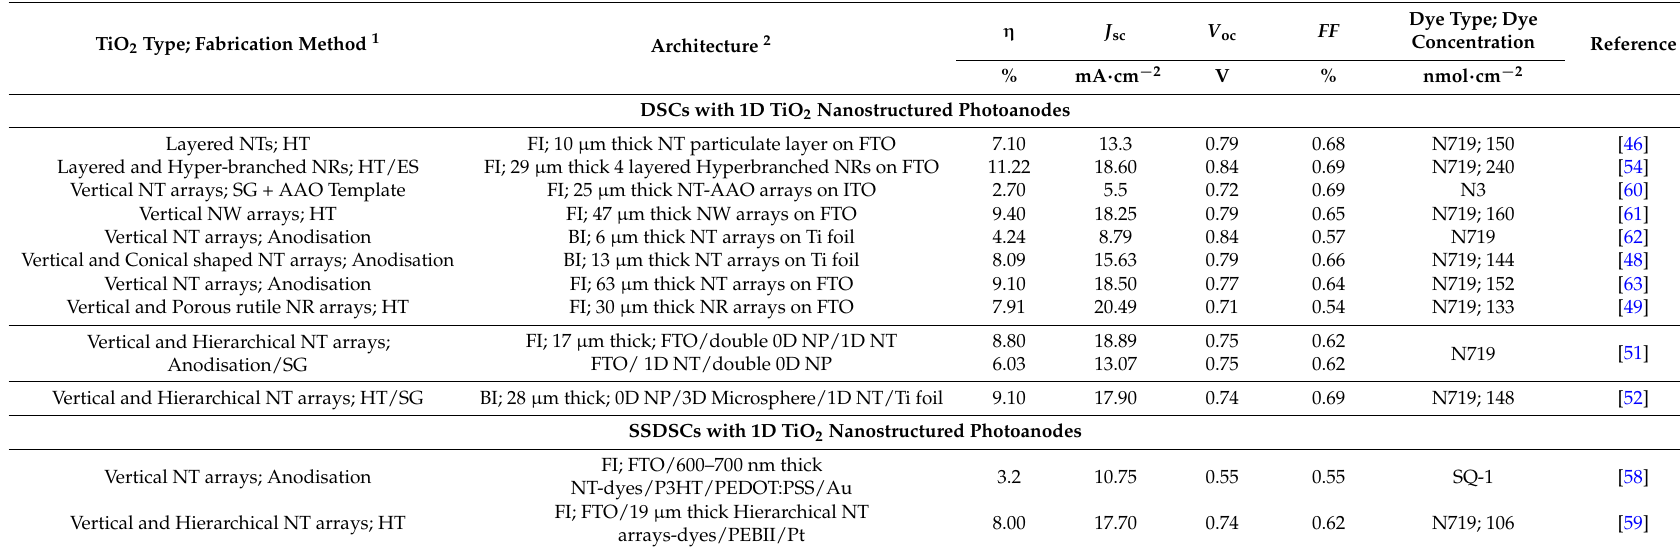
Table 1. Summary of the photovoltaic characteristics for DSCs and SSDSCs using 1D TiO 2 nanostructured